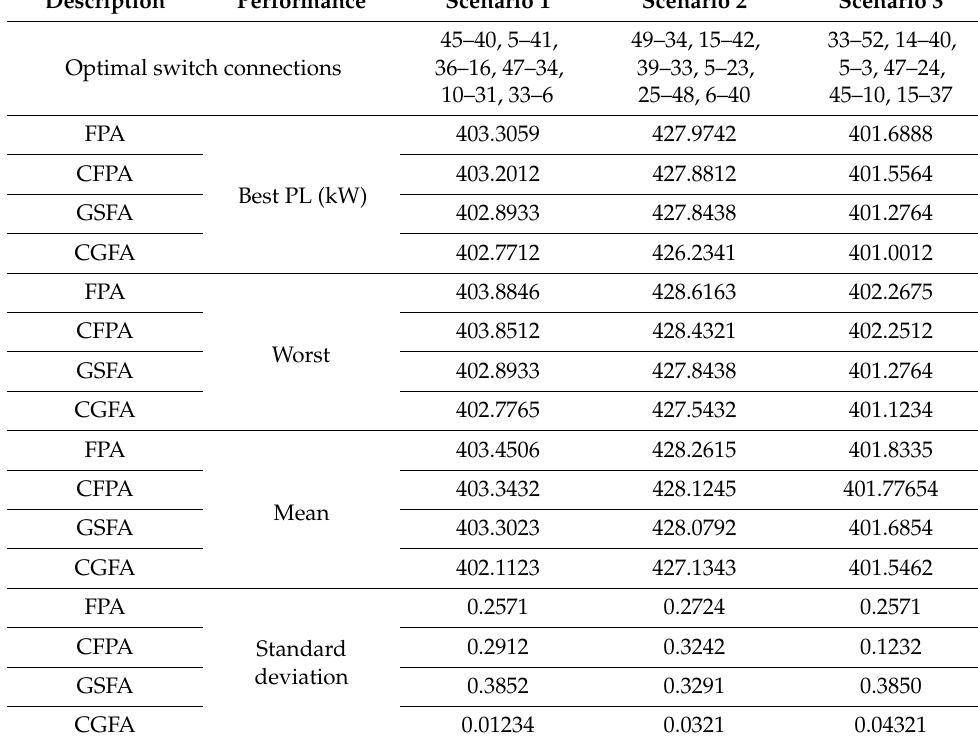
Table 7. Optimal tie-switch connections and power loss with the DNR in an SC